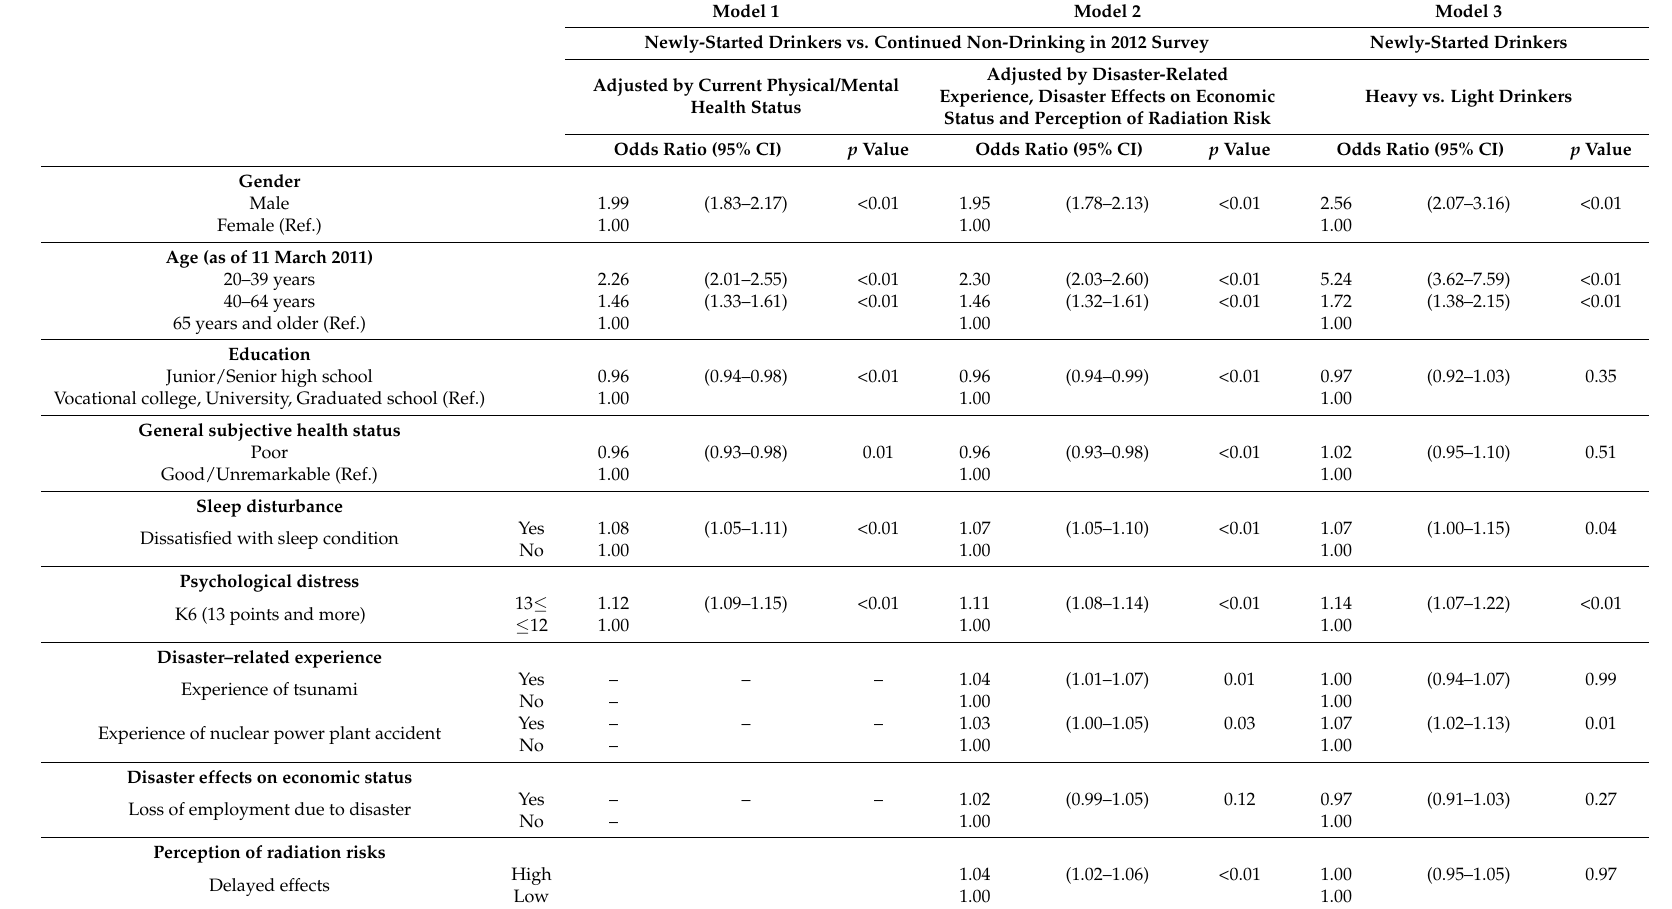
Table 3. Multivariate logistic regression analysis of newly-started drinkers